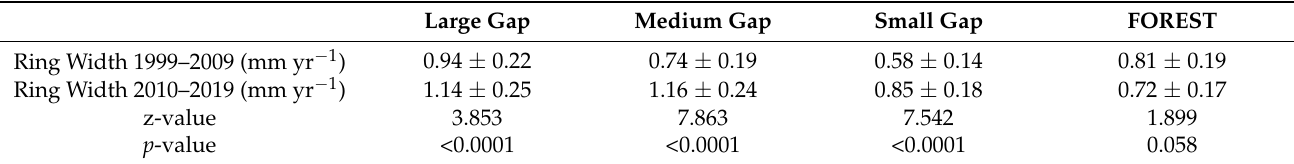
Table 4. Tree rings widths sampled in gaps and in forest, before and after gap’s